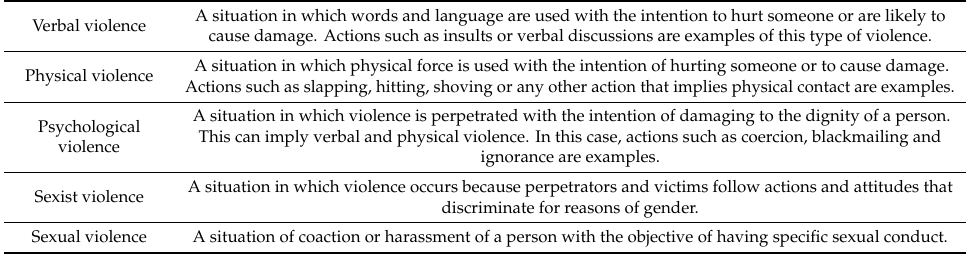
Table 1. Definitions of the di ff erent types of violence considered in this thematic analysis. Verbal